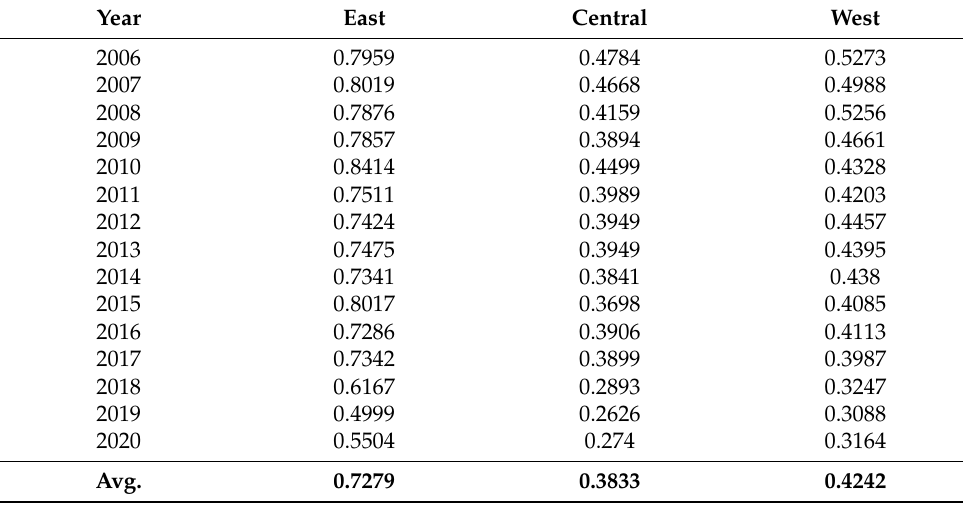
Table A2. Meta frontier of all three regions over the period